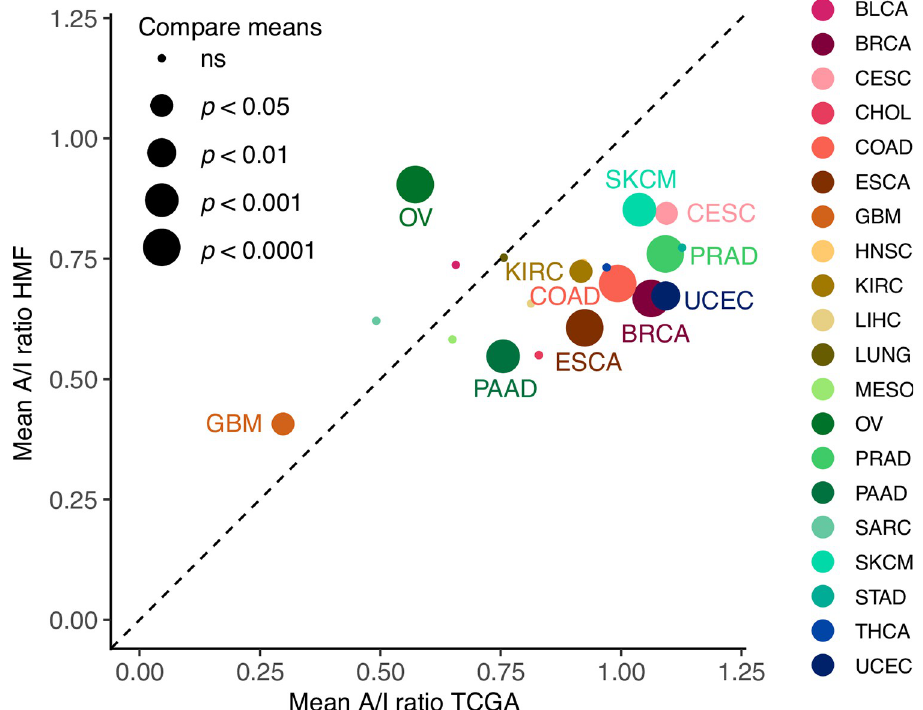
Fig 3. Comparing the A/I ratio between primary and metastatic tumours. The mean A/I ratio for 20 overlapping cancer types in the TCGA and HMF cohorts. The mean ratio of primary tumours from TCGA on the x-axis and mean ratio of metastatic tumours from the HMF cohort on the